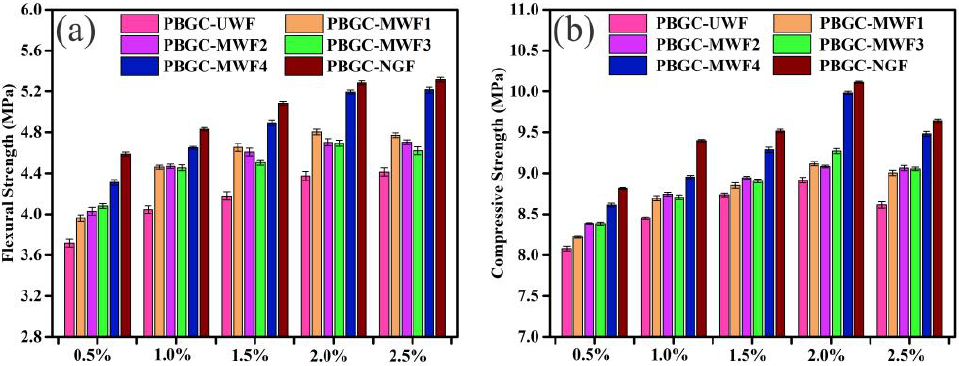
Figure 13. The effect of the MWF and NGF dosage on the mechanical properties. ( a ) Flexural strength; ( b ) Compressive strength.